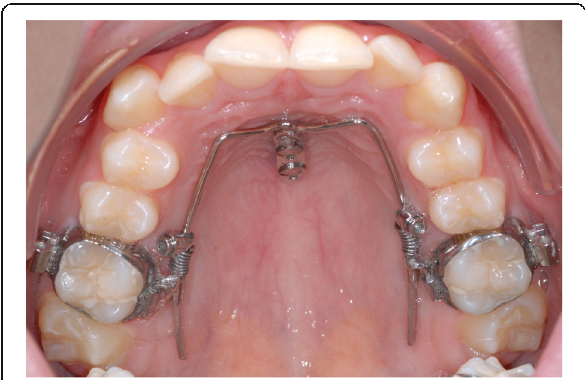
Fig. 1 Orthodontic sliding mechanics for sagittal molar